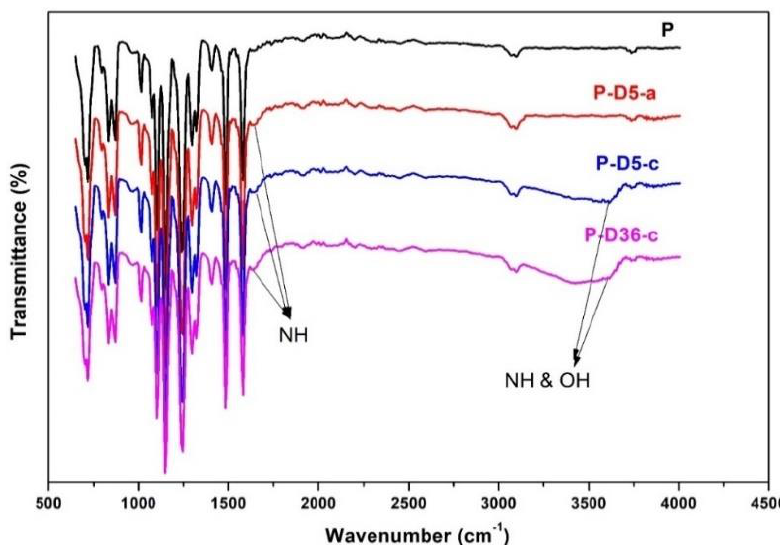
Figure 2. The changes in chemical functional groups of PES membranes before and after modification.